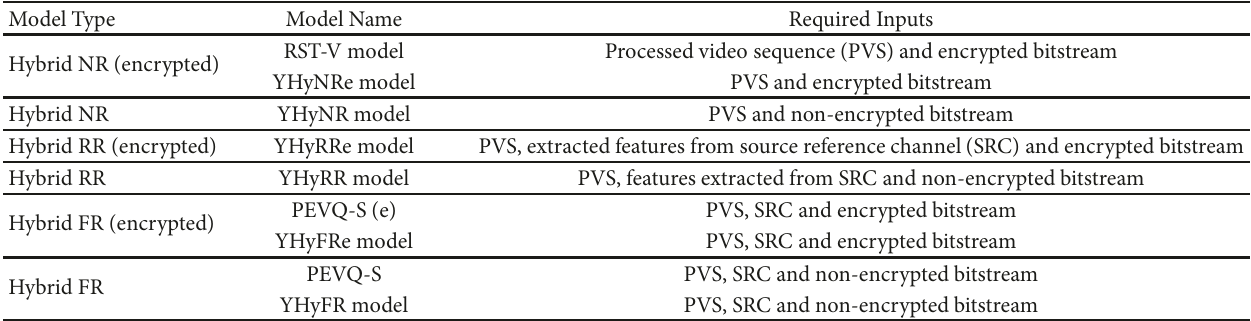
Table 13: Model input across different